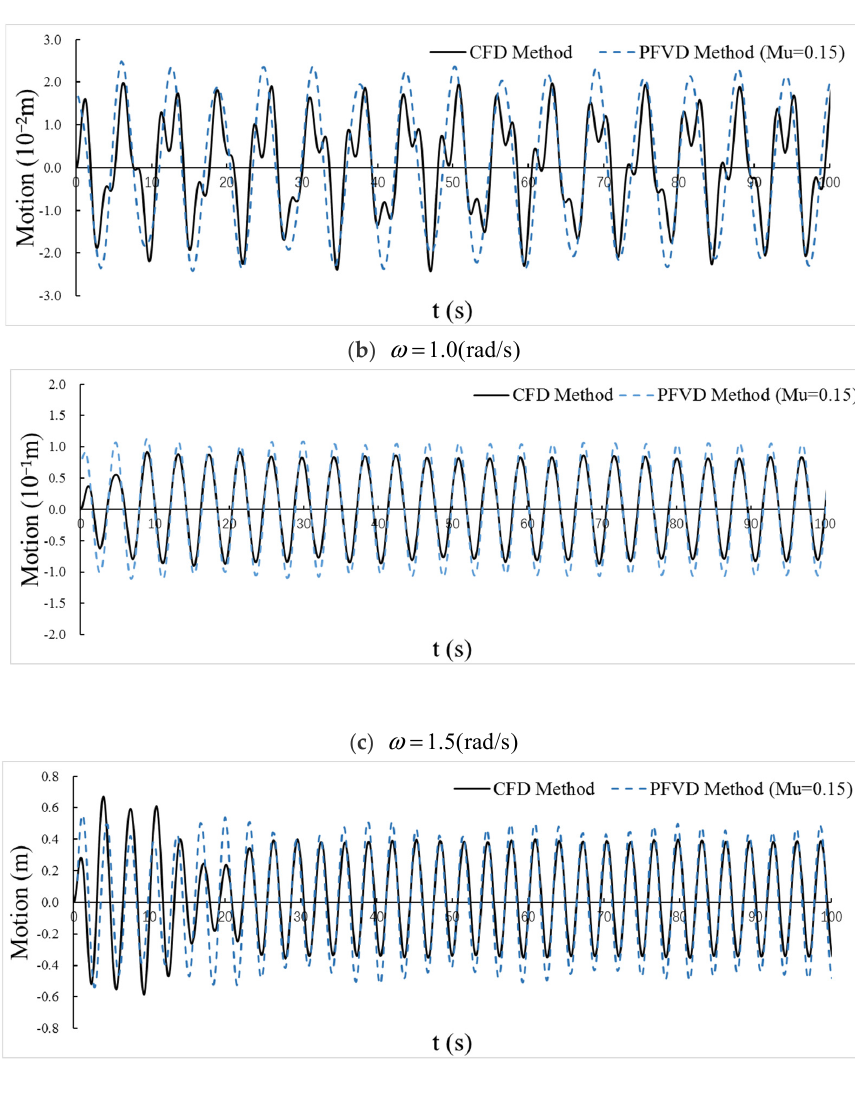
Figure 14. The motion response with different frequencies.